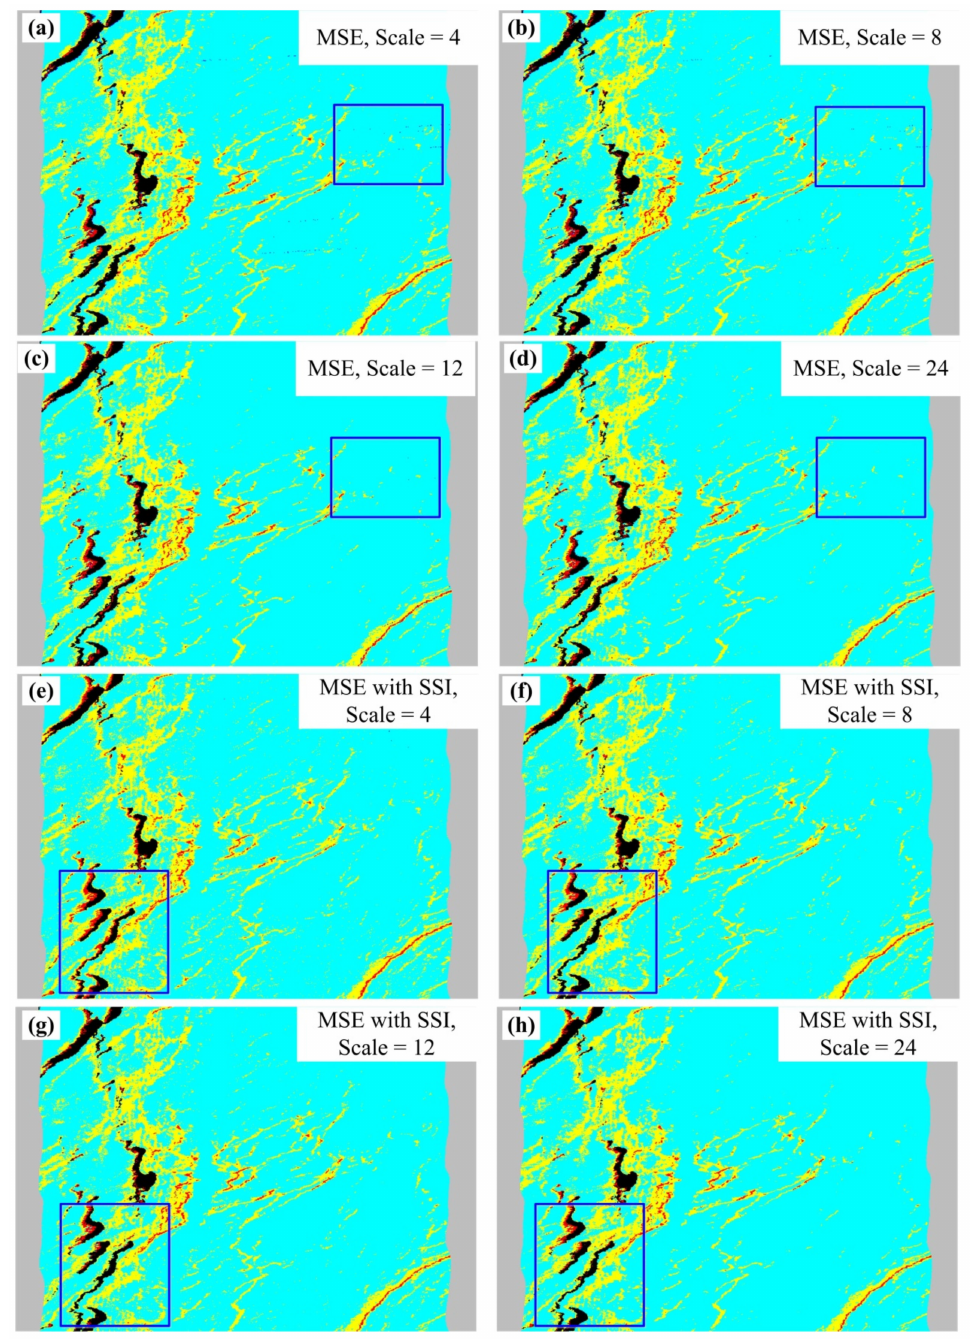
Figure 12. The detection results produced by the MSE method ( a – d ) and MSE method with SSI ( e – h ) on different scales. Result differences could be observed in the blue